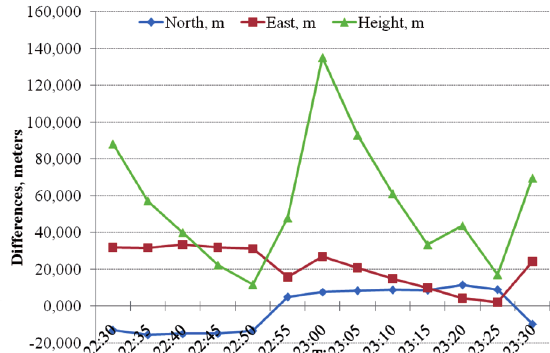
Fig. 3. Values of CPOS station called NYA1 in